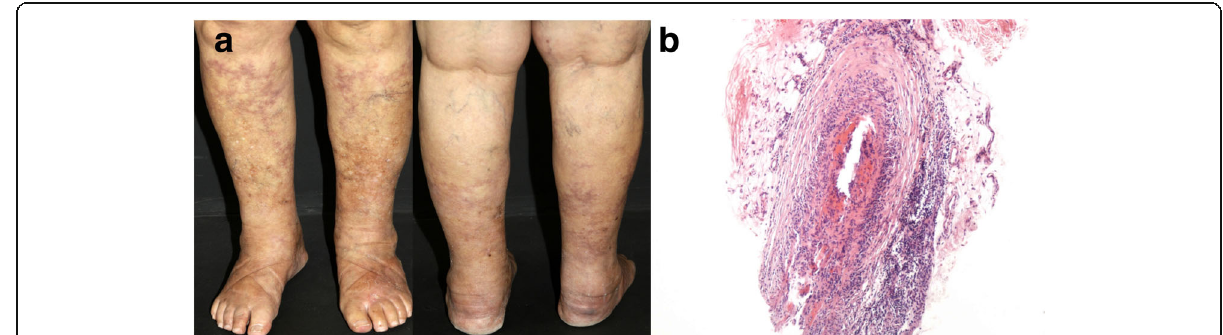
Fig. 5 Cutaneous polyarteritis nodosa. a Multiple infiltrated erythematous nodules mixed with livedo racemosa on the lower legs. b Vasculitis of medium-size-artery at the septa of the subcutaneous fat tissue. H&E,